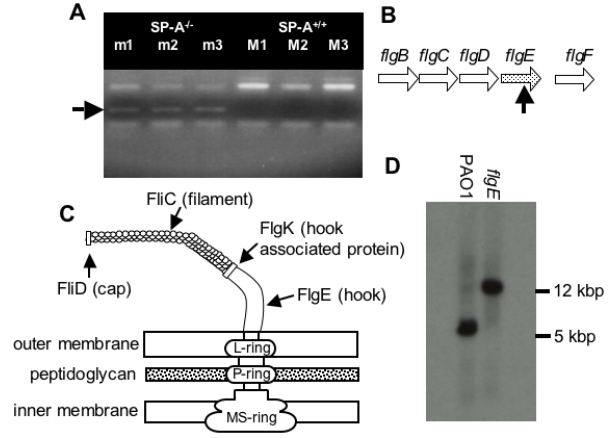
Figure 1. The Flagellar Mutant flgEIs Preferentially Cleared from the Lungs of SP-A + / + Mice. (A) Pools of 72 uniquely-tagged mutants were intranasally inoculated into three SP-A + / + (M1, M2, M3) and three SP-A 2 / 2 (m1, m2, m3) mice. Mouse lungs were harvested, homogenized and plated. Bacteria colonies were collected for genomic DNA extraction. PCR-amplification of tags was performed to screen for the presence or absence of each of the 72 mutants. The band indicative of the flgE mutant was present in the SP-A 2 / 2 pool, but absent in the SP-A + / + pool. (B) Genetic organization of the flg operon in P. aeruginosa . The horizontal arrows ( flgB, flgC, flgD, flgE, flgF ) represent transcriptional directions of the genes coding for flagella proteins. The vertical black arrow indicates the approximate insertion site within the mutated open reading frame of flgE . (C) A schematic representation of flagellar structure. FliC is flagellar filament protein, FliD is flagellar cap protein, FlgE is flagellar hook protein, and FlgK is flagellar hook associated protein. (D) Restriction fragment length polymorphism analysis between wild-type PA01 and flgE mutant indicates that the flgE mutation was caused by transposon insertion into the cloned gene.